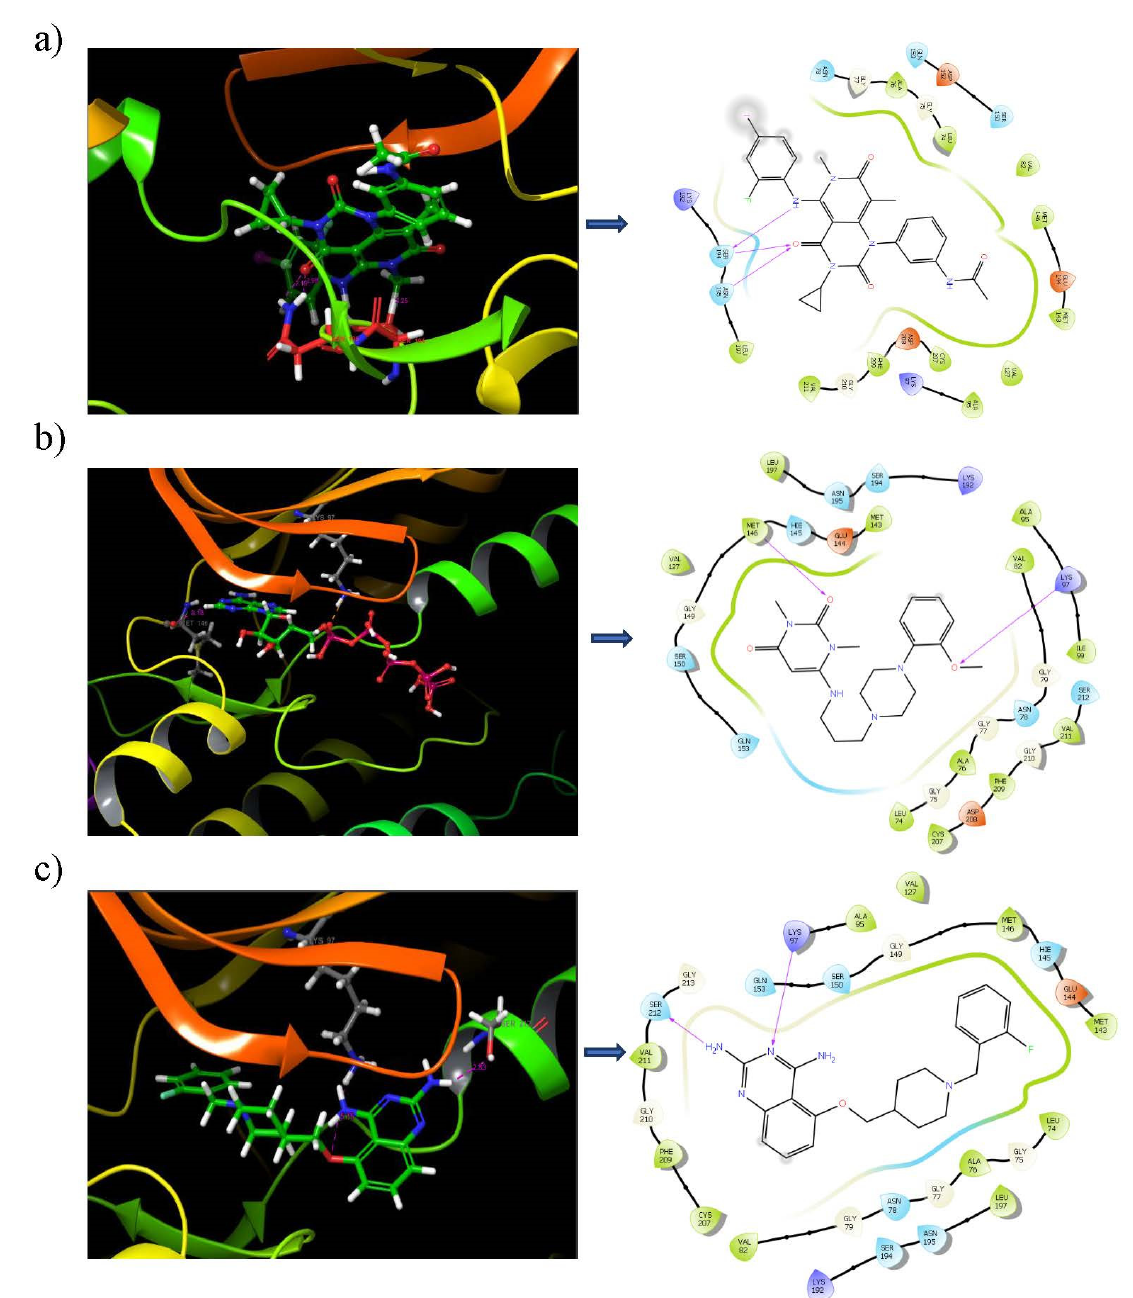
Figure 2. Ligand interaction diagram of the hit compounds. ( a ) Reference; ( b ) DB12661; ( c ) DB07642 with MEK1 receptor.